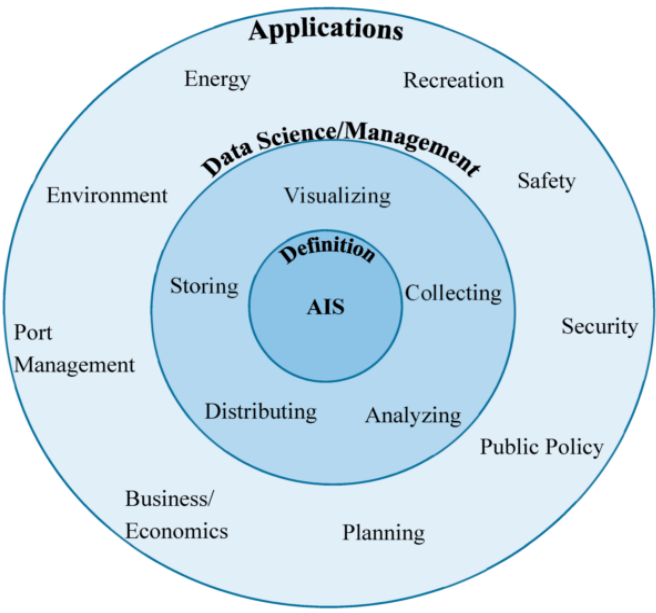
J. Mar. Sci. Eng. 2019 , 7 , x FOR PEER REVIEW Figure 1. Automatic identification systems (AIS) and its applications. Figure 1. Automatic identification systems (AIS) and its applications.